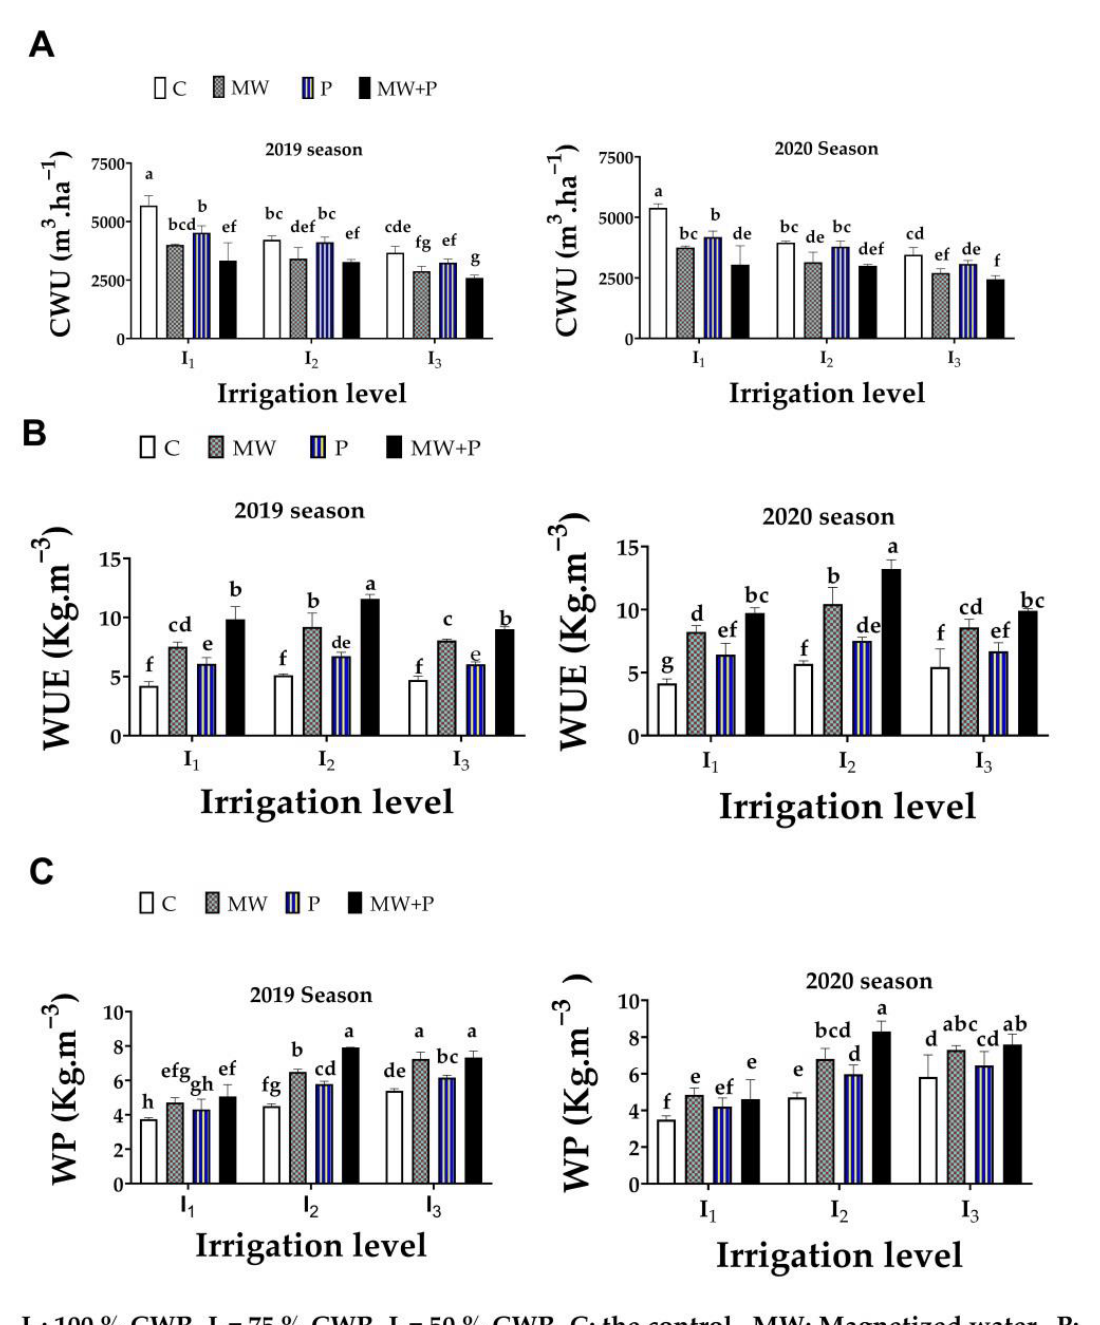
Figure 4. Effect of MW, P, and MW + P on consumptive water use (CWU) ( A ), water use efficiency (WUE) ( B ), and water productivity (WP) ( C ) of “Taifi” pomegranate shrubs grown under different irrigation regimes (I 1 , I 2 , and I 3 ), based on CWR, during the 2019 and 2020 seasons. Values are the means ± SD. DMRT was used for mean comparisons at p ≤ 0.05.